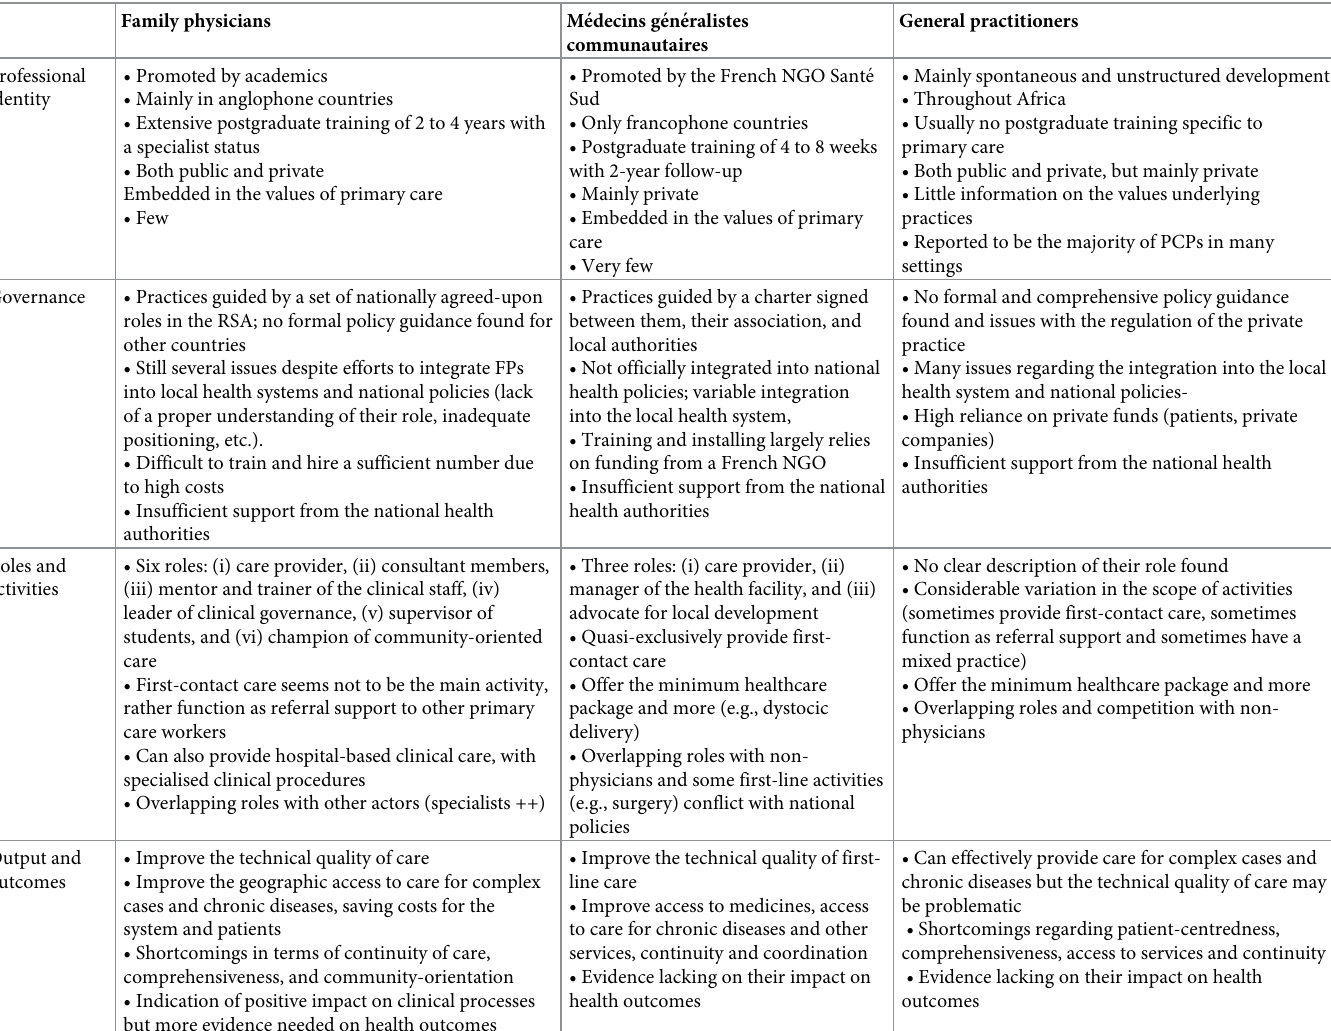
Table 5. Main characteristics and key issues related to PCPs’ practices in